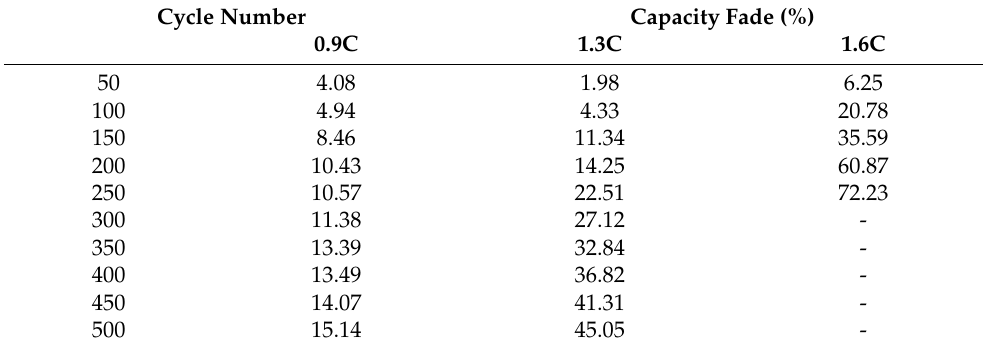
Figure 8. Comparison of battery degradation model performance with experimental and simulated data for individual battery capacity fades at 0.9C, 1.3C, and 1.6C. Table 3. The degree of capacity fade at 0.9C, 1.3C, and 1.6C for every 50 cycles throughout its lifetime.